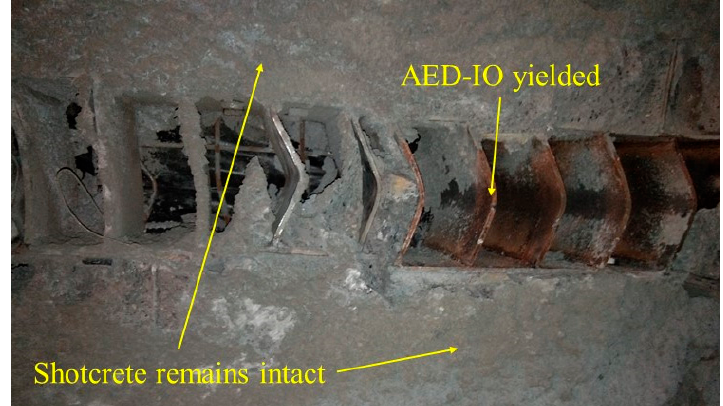
Figure 19. AED-IO deformation state.